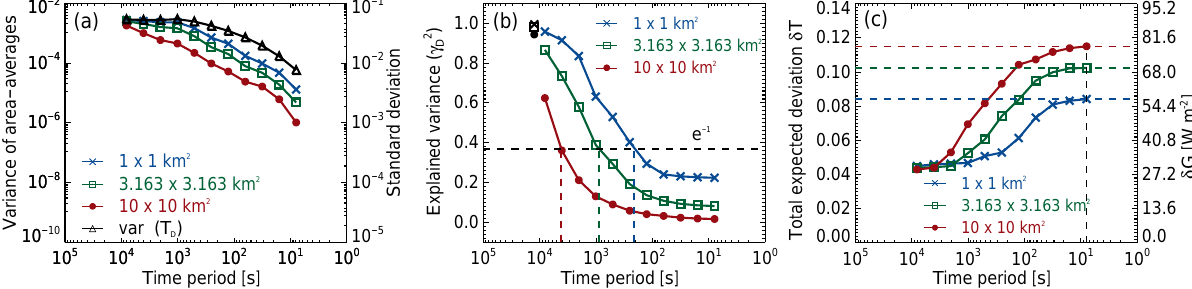
Figure 5. Spatiotemporal characteristics derived from the pyranometer network under broken-cloud conditions during HOPE-Jülich. This figure illustrates the origin of deviations between a point measurement (labelled as var( T D ) in the legend) and a domain-averaged value (representativeness error) for broadband solar atmospheric transmittance and irradiance for different domain sizes. (a) Power spectra of transmittance for a point measurement and domains with different sizes; (b) explained variance of temporal fluctuations in a point mea- surement and a domain average as function of period; (c) total expected deviation between a point measurement and a domain average for transmittance and irradiance as a function of averaging, assuming a value of 680Wm − 2 for the incoming solar irradiance at the top of atmosphere. The time period of fluctuations (inverse of their frequency) is shown logarithmically on the x axis. Adapted from Madhavan et al. (2017).